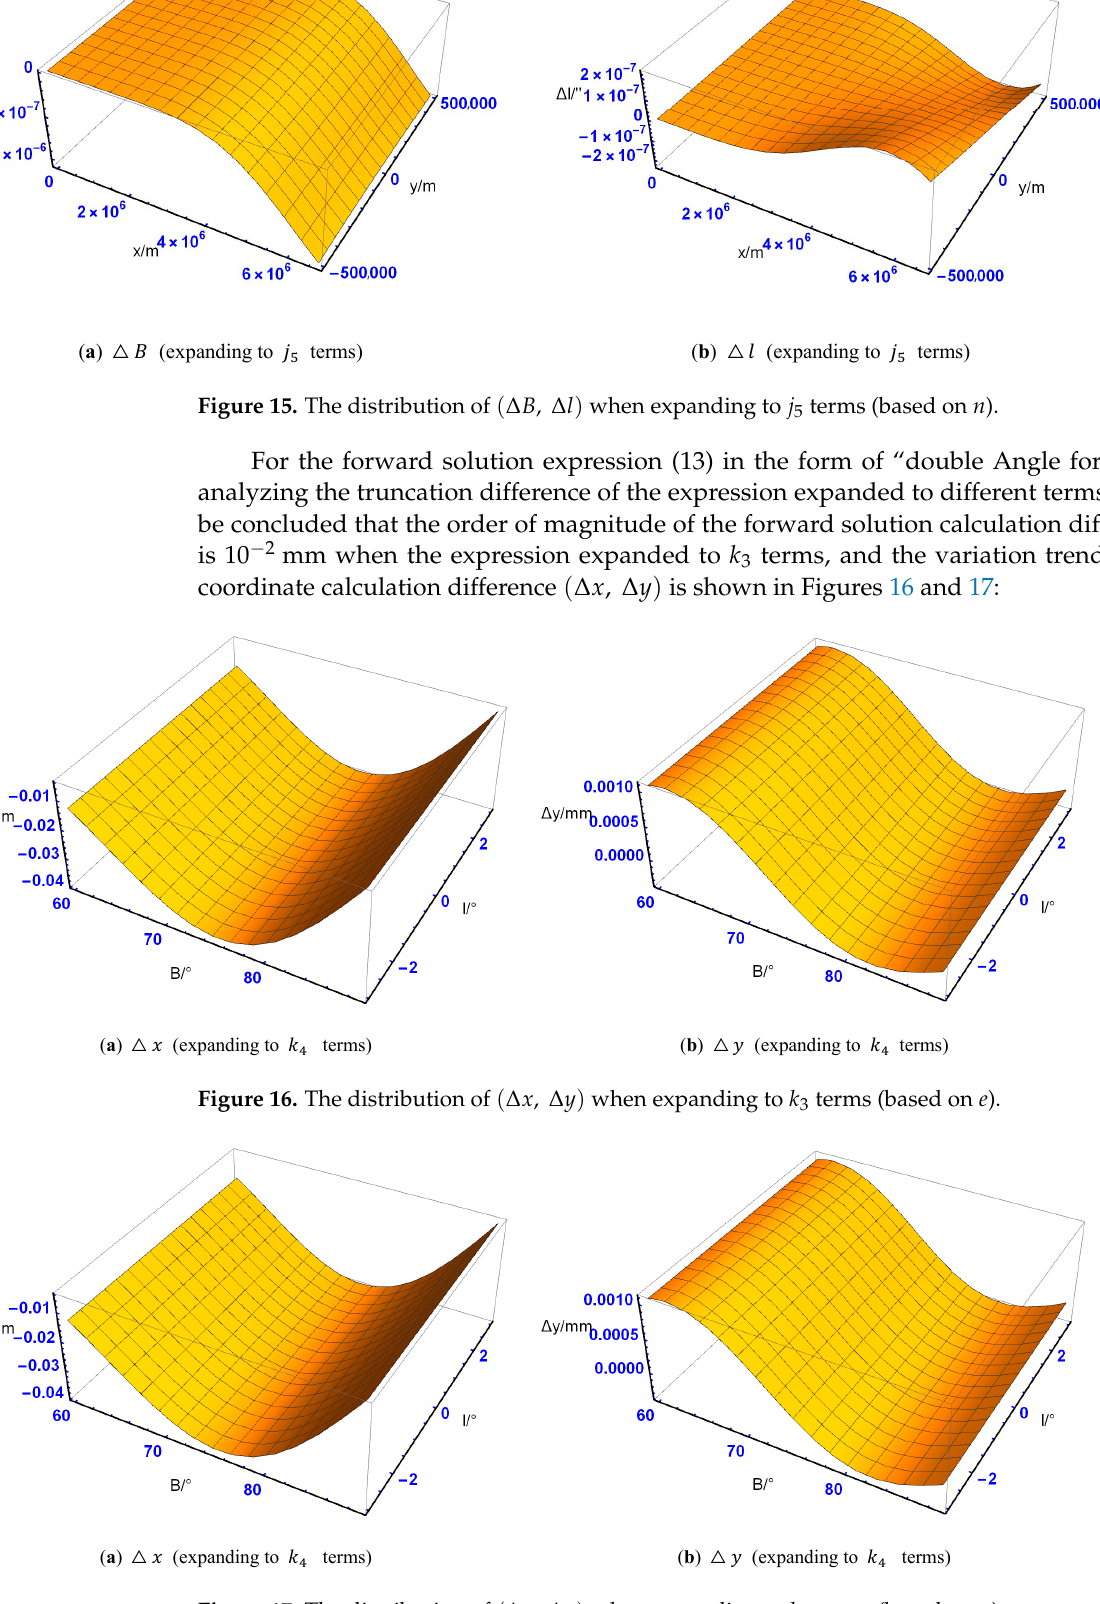
Figure 17. The distribution of ( ∆ x , ∆ y ) when expanding to k 3 terms (based on n ). For the inverse solution expression (15) in the form of “double Angle form”, by ana- lyzing the truncation difference of the expansion to different terms, it can be concluded that the order of magnitude of calculation difference of inverse solution when the